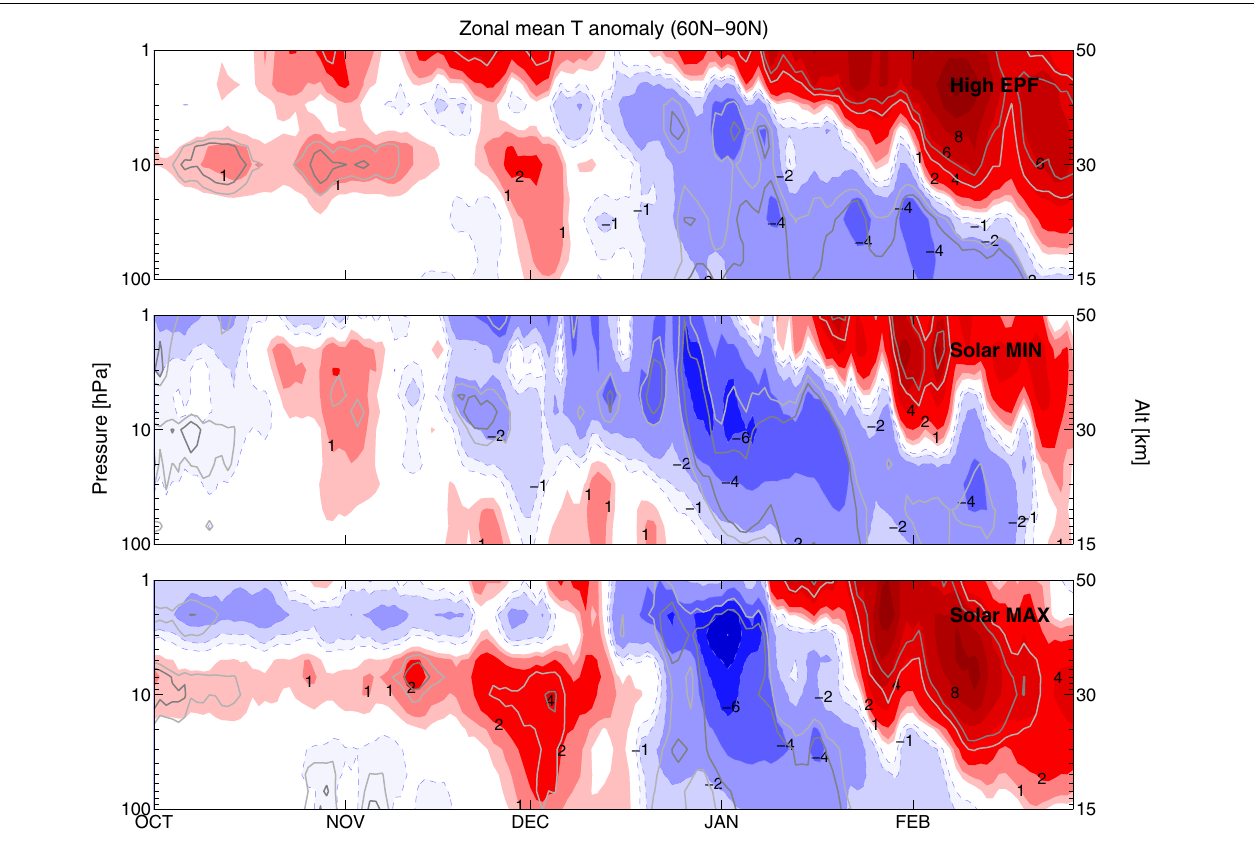
FIGURE 3 | Temporal propagation of temperature anomalies: Daily 60–90 ◦ N zonal mean temperature (T) anomaly (difference from the ERA dataset mean) from Oct to Feb. Top: High EPF conditions. Middle: Solar min. Bottom: Solar max. Contours are